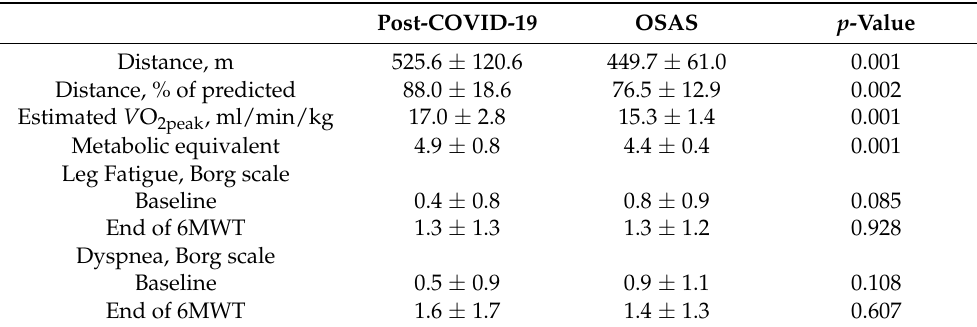
Table 2. 6MWT results between groups. Data are expressed as mean ± standard deviation. Post-COVID-19 OSAS p -Value Distance, m 525.6 ± 120.6 449.7 ± 61.0 0.001 Distance, % of predicted 88.0 ± 18.6 76.5 ± 12.9 0.002 Estimated V O 2peak , ml/min/kg 17.0 ± 2.8 15.3 ± 1.4 Metabolic equivalent 4.9 ± 0.8 Leg Fatigue, Borg scale Baseline 0.4 ± 0.8 Dyspnea, Borg scale Baseline End of 6MWT 0.607 Abbreviations: 6MWT: 6-minute walk test; V O 2peak : oxygen uptake in the maximal